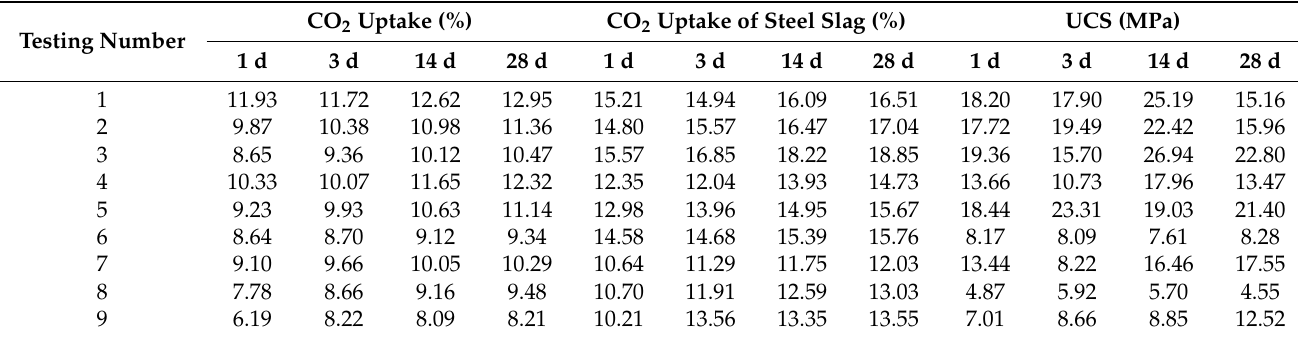
Table 3. Orthogonal experimental results of CO 2 uptake and UCS